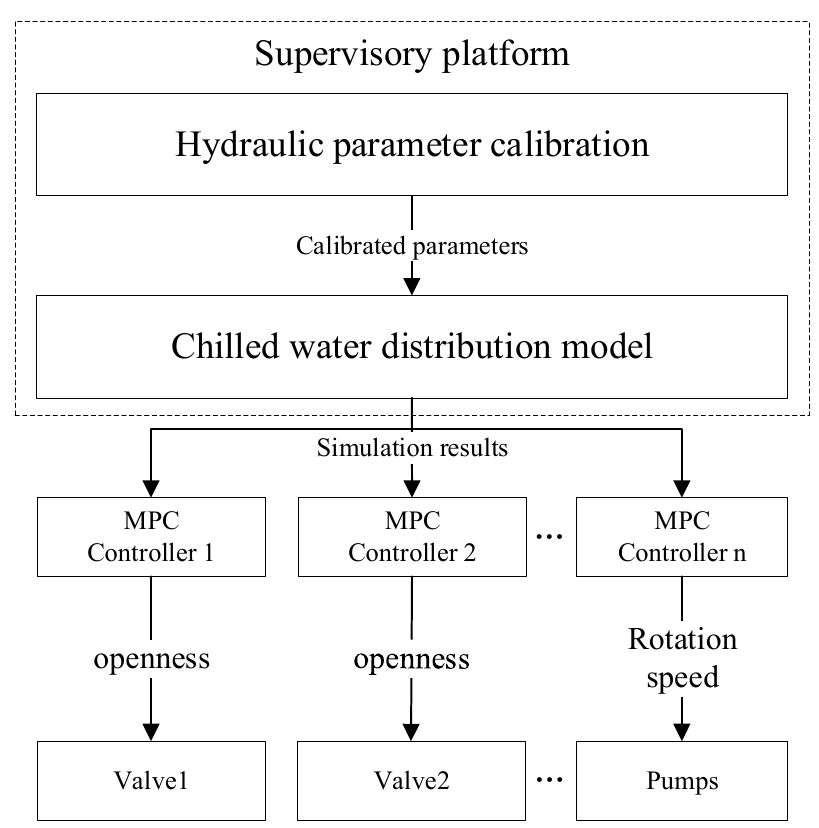
Figure 3. A schematic control diagram of the proposed MPC method.